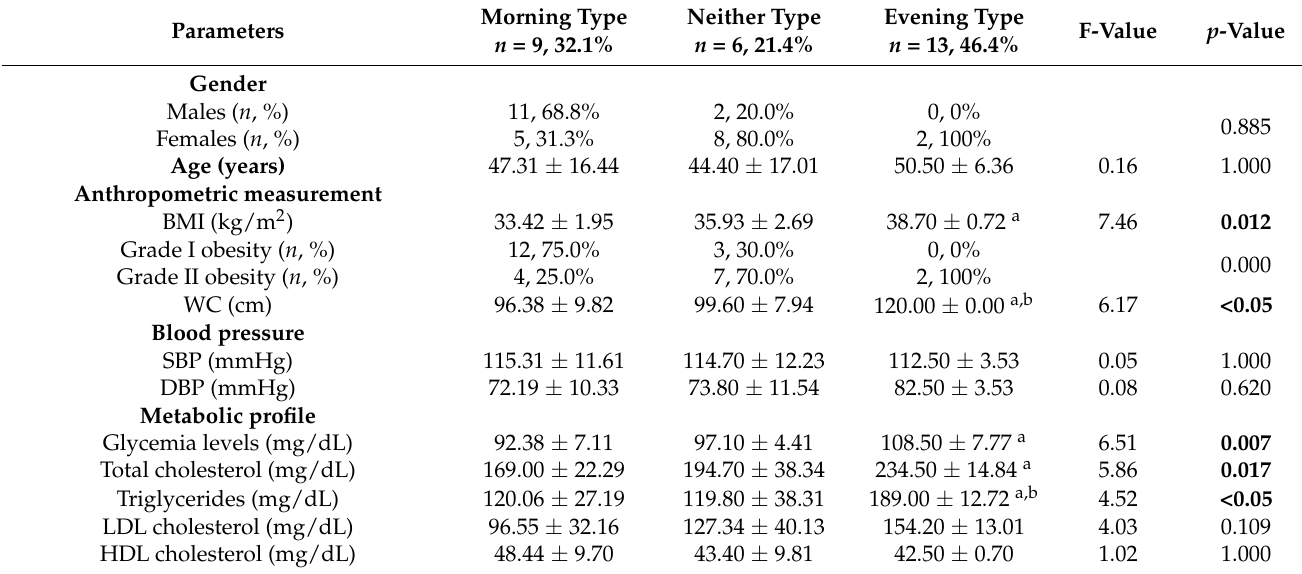
Table 4. Differences in study parameters of control group according to chronotype categories.